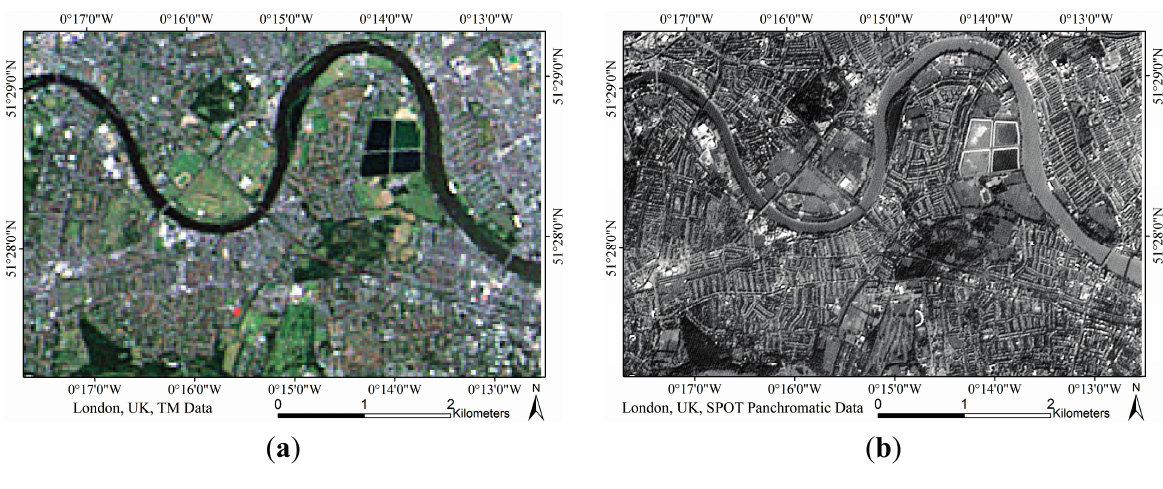
Figure 3. ( a ) Multispectral TM image (TM, 28-m resolution, 400 × 600 pixels after resampling and resizing). ( b ) Panchromatic SPOT image (SPOT, 10-m resolution, 400 × 600 pixels after